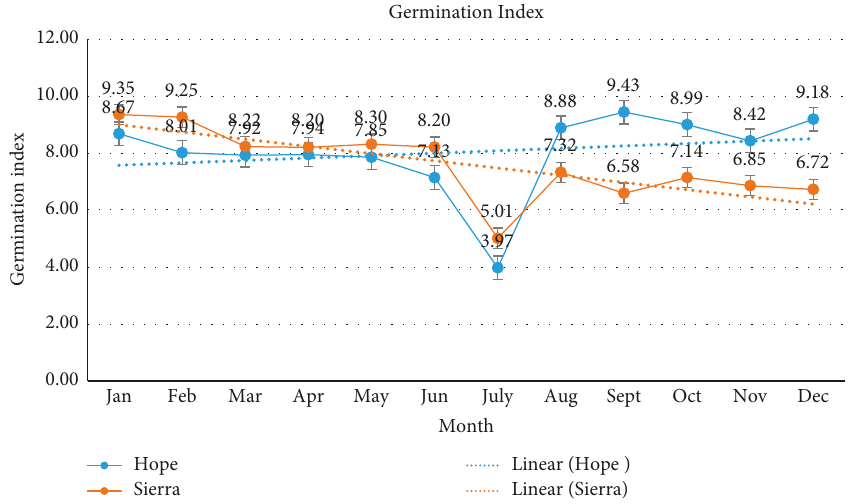
Figure 5: Comparison of the germination index trends for Hope and Sierra malting barley varieties over the 12-month storage